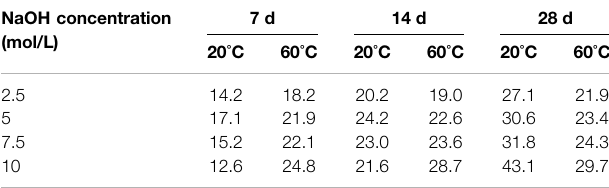
TABLE 3 | UCS of specimens prepared with mixed activator